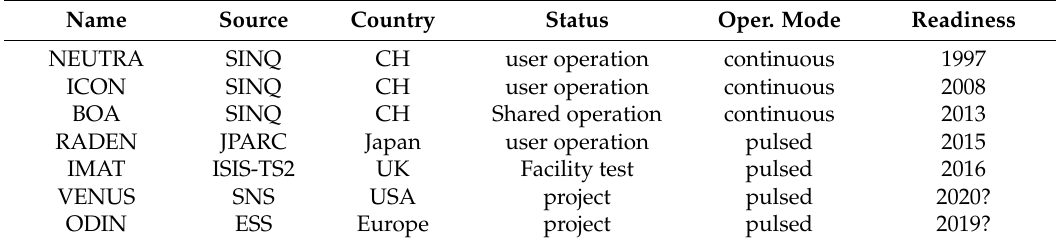
Table 1. Neutron Imaging (NI) facilities at spallation neutron